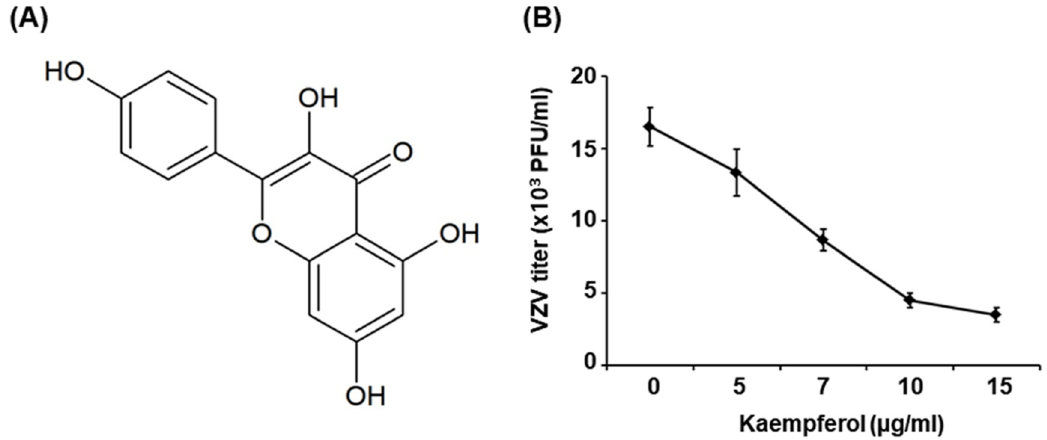
Figure 1 . Anti-VZV activity of kaempferol. ( A ) Structure of kaempferol. ( B ) HFFs were inoculated with serially diluted cell-associated VZV-YC01 and treated with kaempferol at the indicated concentrations. Cells were re-treated with the same concentrations of kaempferol 3 days after inoculation. At 6 days after inoculation, cells were stained with 0.3% crystal violet and the number of plaques was counted.